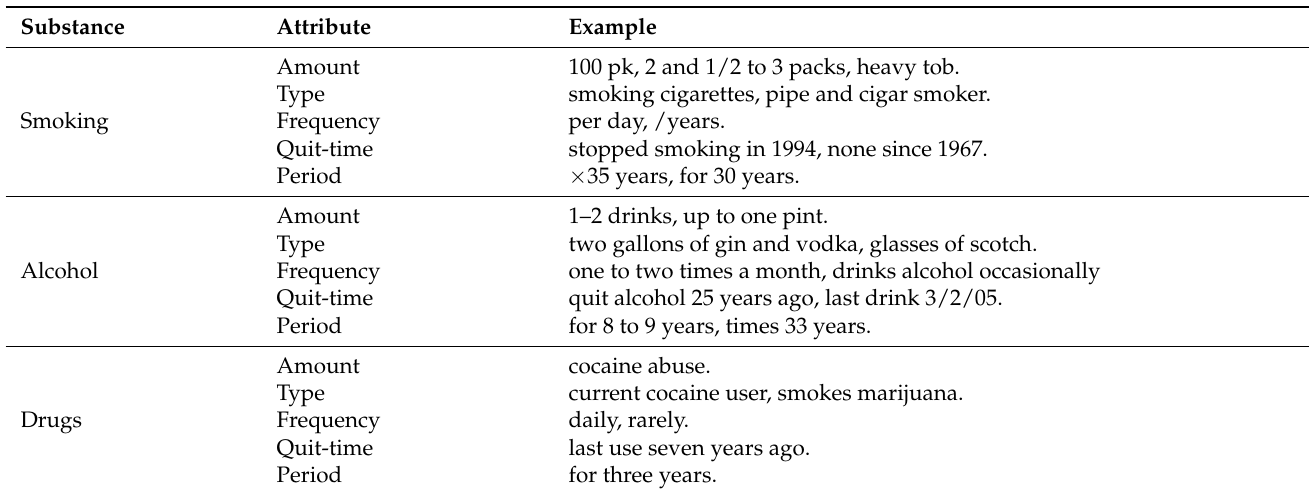
Table 2. Examples of attributes for smoking, alcohol, and drug use.